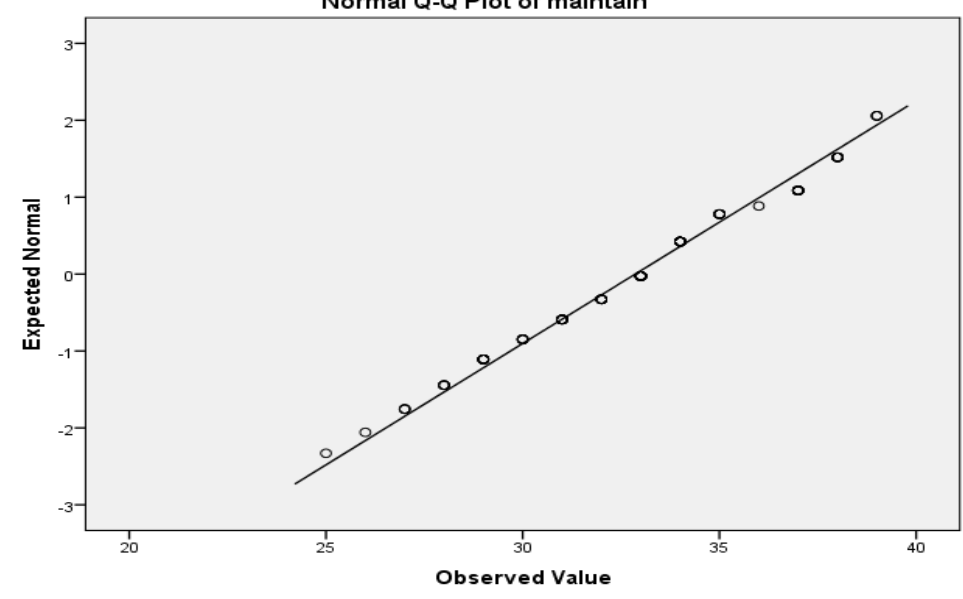
Figure 6. Q-Q plot for the number of maintenances. Figure 6. Q - Q plot for the number of maintenances.